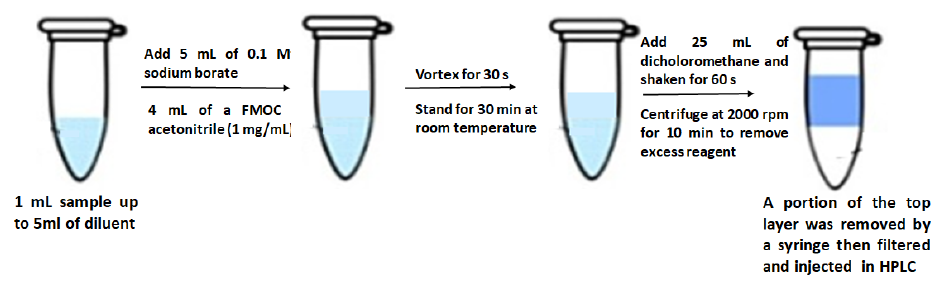
Figure 2. Schematic representation of sample preparation for quantification of ALS.